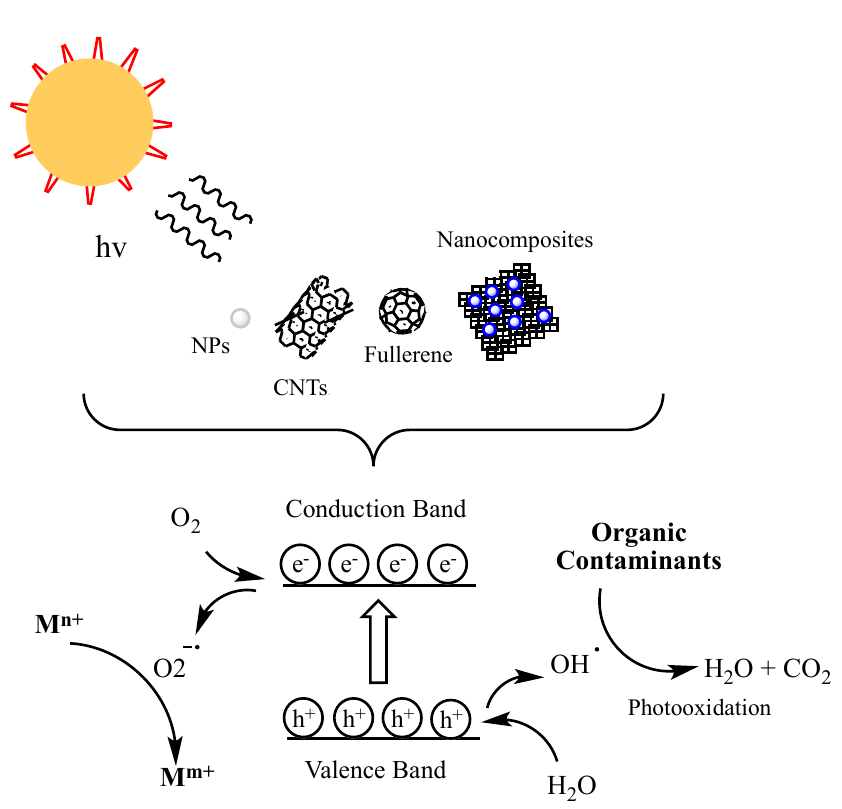
Figure 4. Photocatalytic degradation mechanisms of metal and organic contaminants.